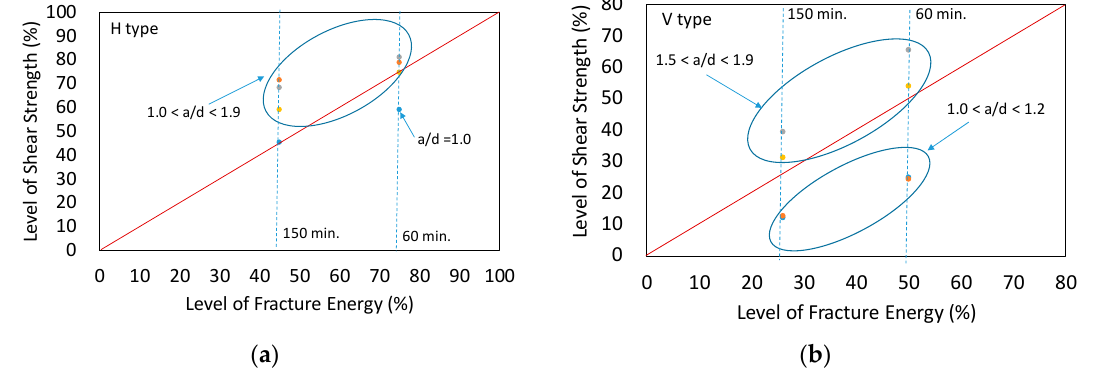
Figure 22. Fracture energy vs Shear strength: ( a ) horizontal type; and ( b ) vertical type.